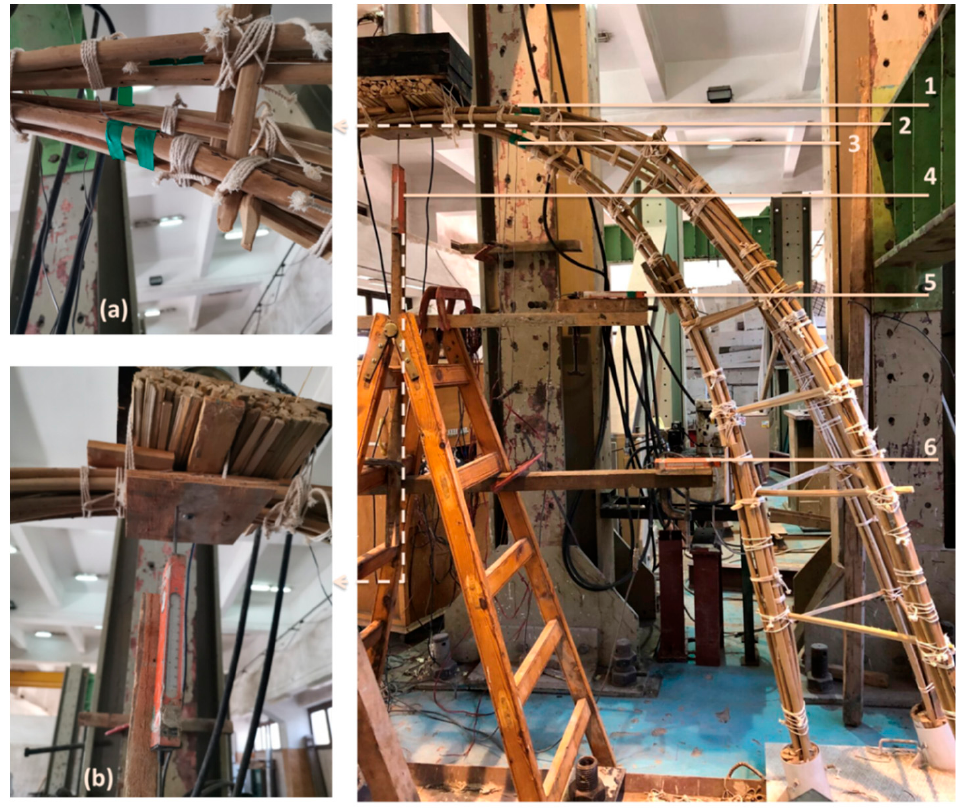
Figure 15. Standard instrumentation of a specimen. (1) Strain gauge No.1. (2) Strain gauge No.2. (3) Strain gauge No.3. (4) Vertical LVDT. (5) Top horizontal LVDT. (6) Bottom horizontal LVDT. ( a ) Fixation of the strain gauges. ( b ) Fixation of LVDT.